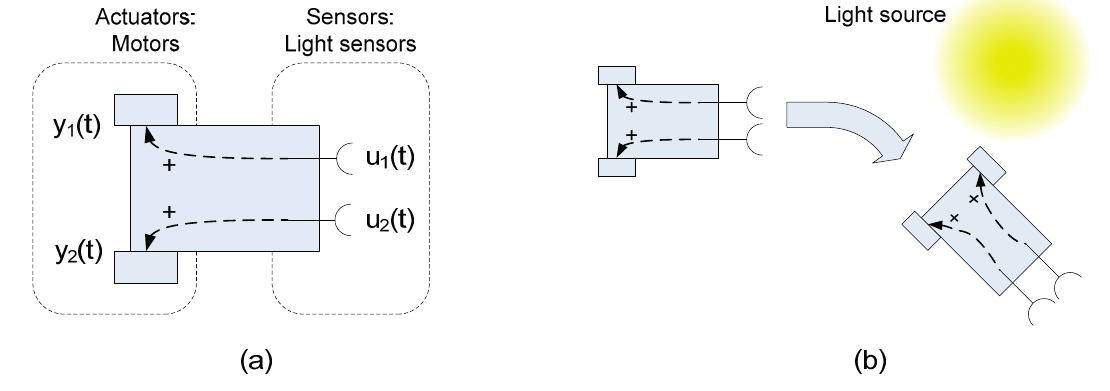
Figure 1. ( a ) Braitenberg vehicle 2 with light sensors and directed wired connection to motors; ( b ) Behaviour resulted in the Braitenberg vehicle 2 when the sensor stimulus (light)